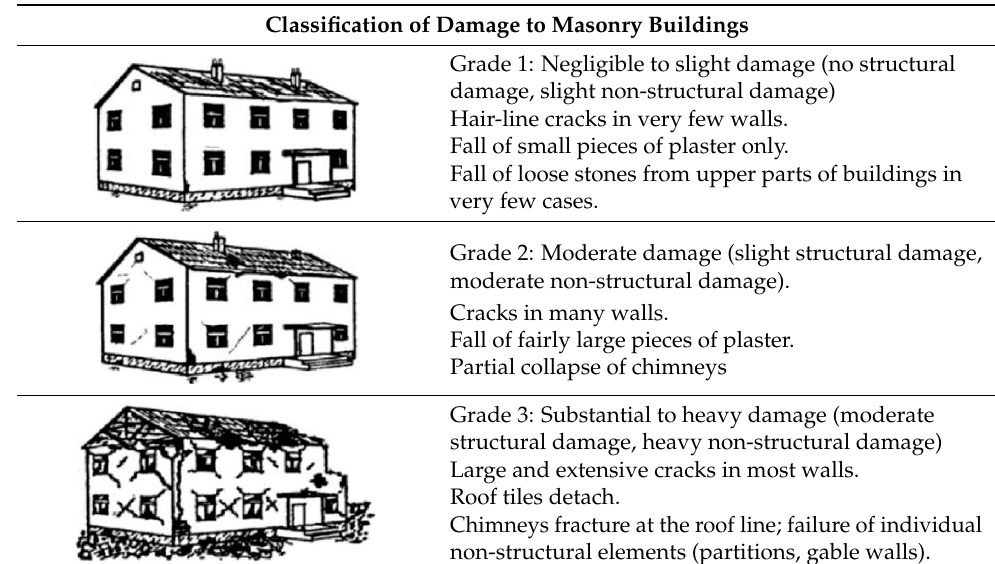
Table 2. Macroseismic Intensity Scale. Classifications used in the European Macroseismic Scale (EMS) for masonry structures (reproduced with permission from G. Grünthal [26]). Classification of Damage to Masonry Buildings